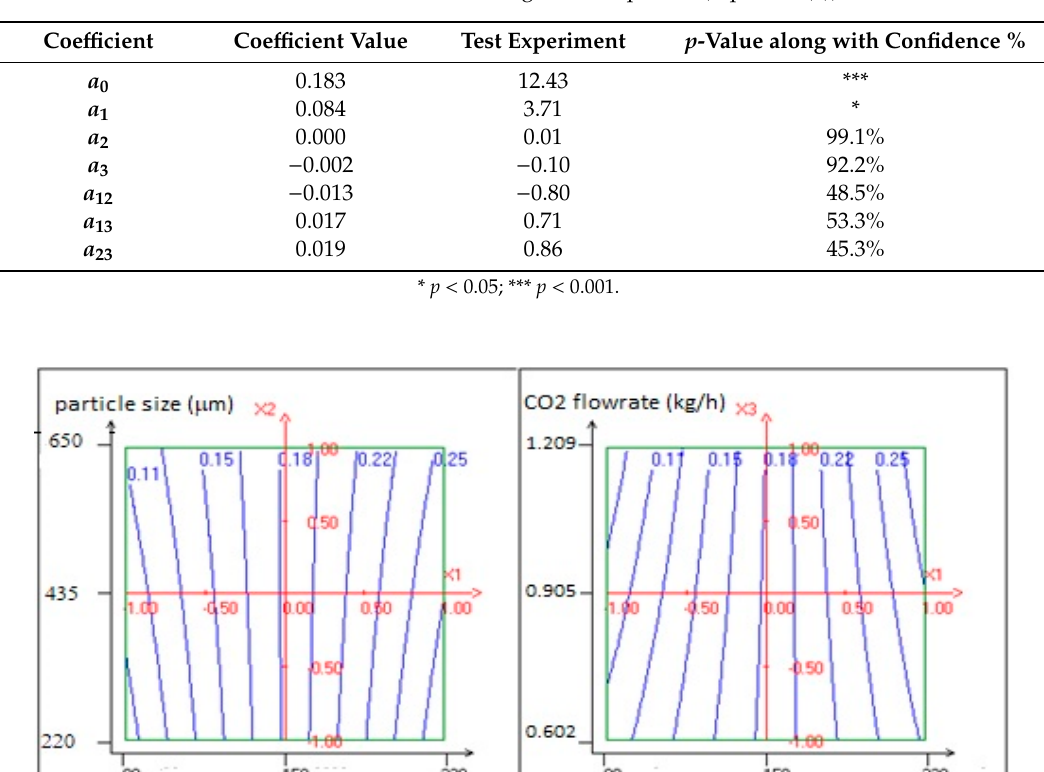
Table 7. Coefficient of a linear regression equation (Equation (1)).